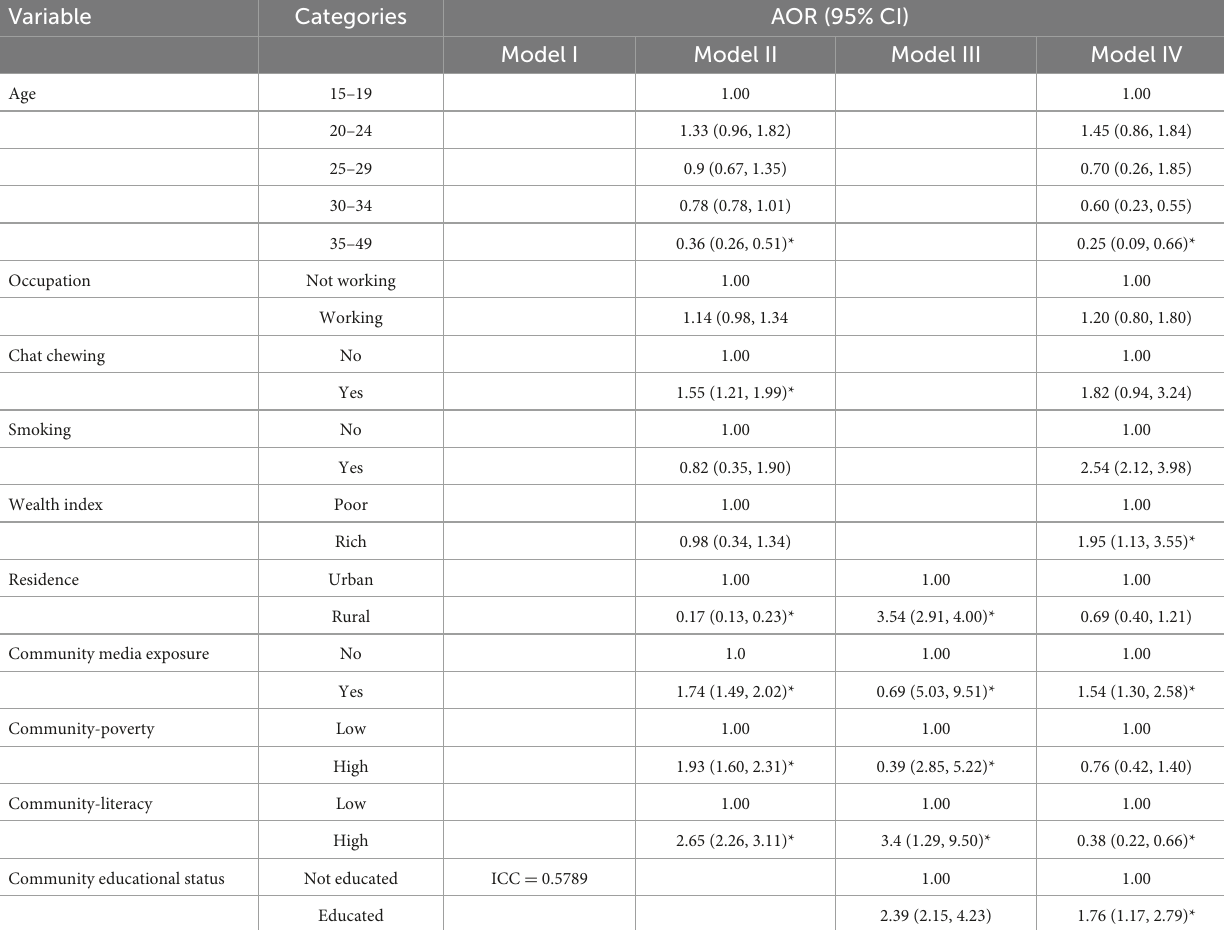
TABLE 5 Factors associated with pre-marital women HIV testing status in Ethiopia.